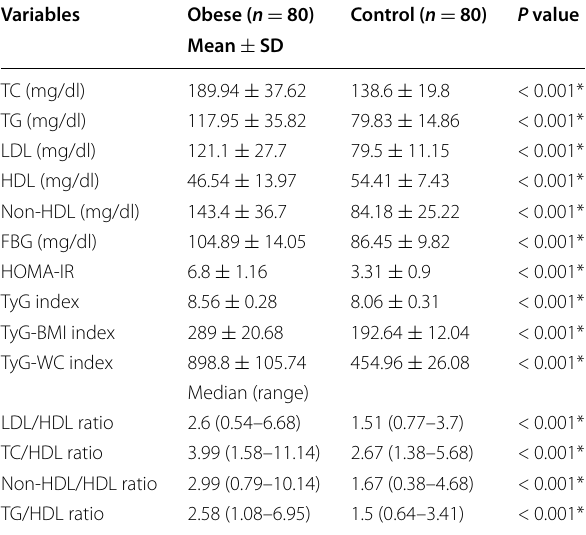
Table 2 Laboratory data of the study